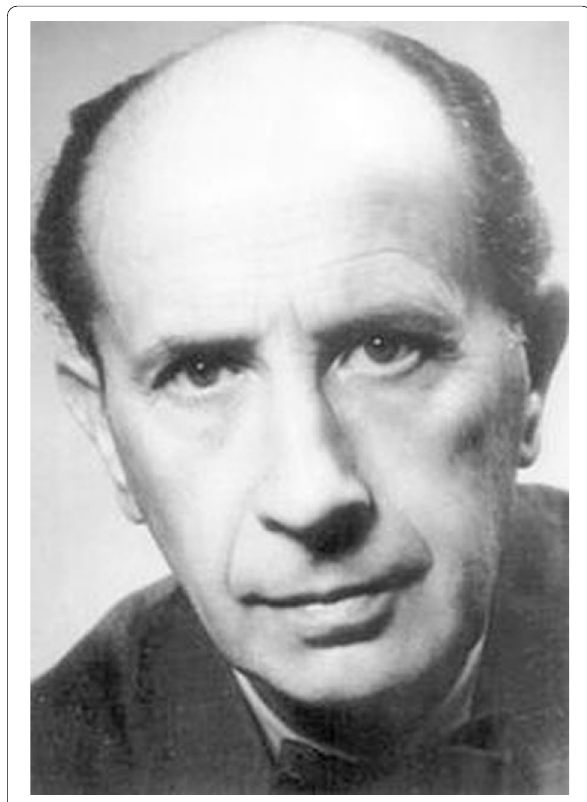
Fig. 3 Karl Kleist. Undated photography. Source : Leonhard K.